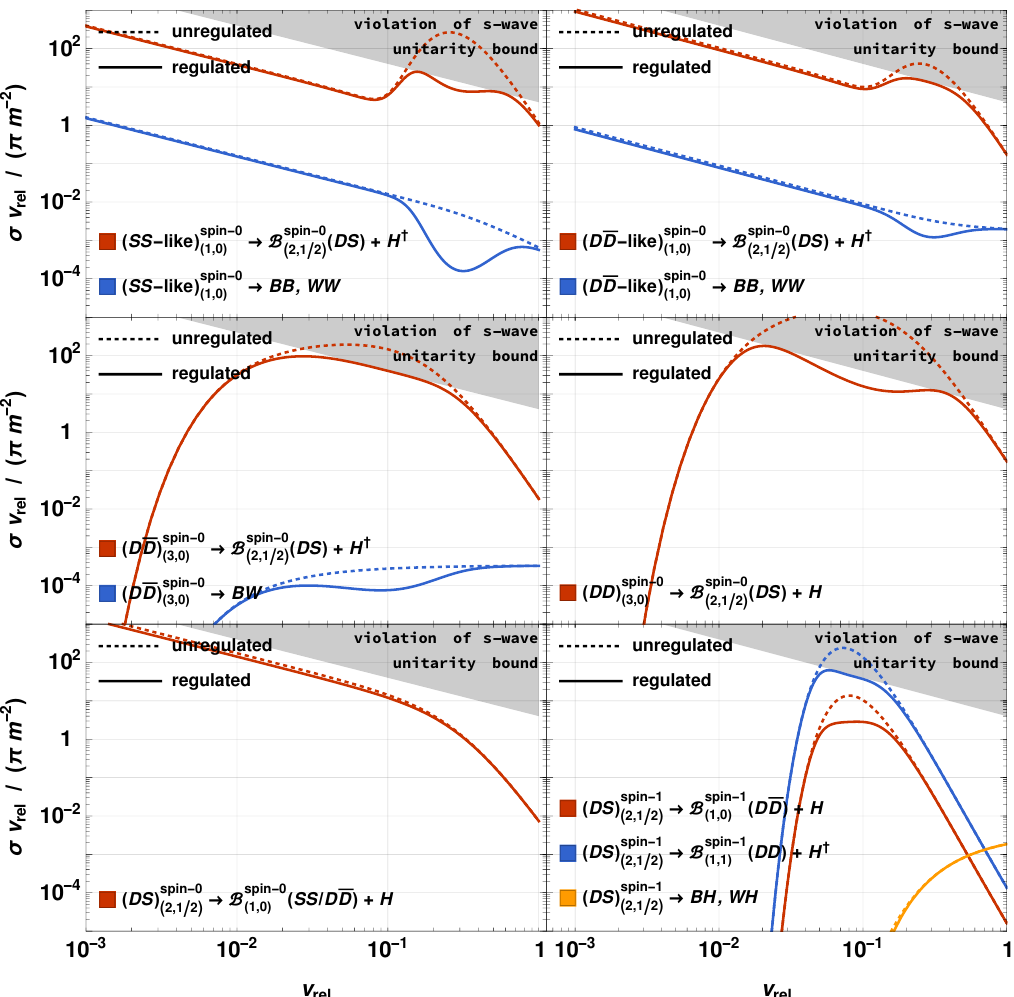
Figure 11 . The effect of the perscription (3.66) on the inelastic cross-sections. While only BSF via Higgs emission approaches or appears to violate the unitarity limit, the regurarisation affects all cross-sections with the same intial state. We have used α = 0 . 2 , m = 50 TeV and T = 300 GeV H which corresponds to m ’ 168 GeV H